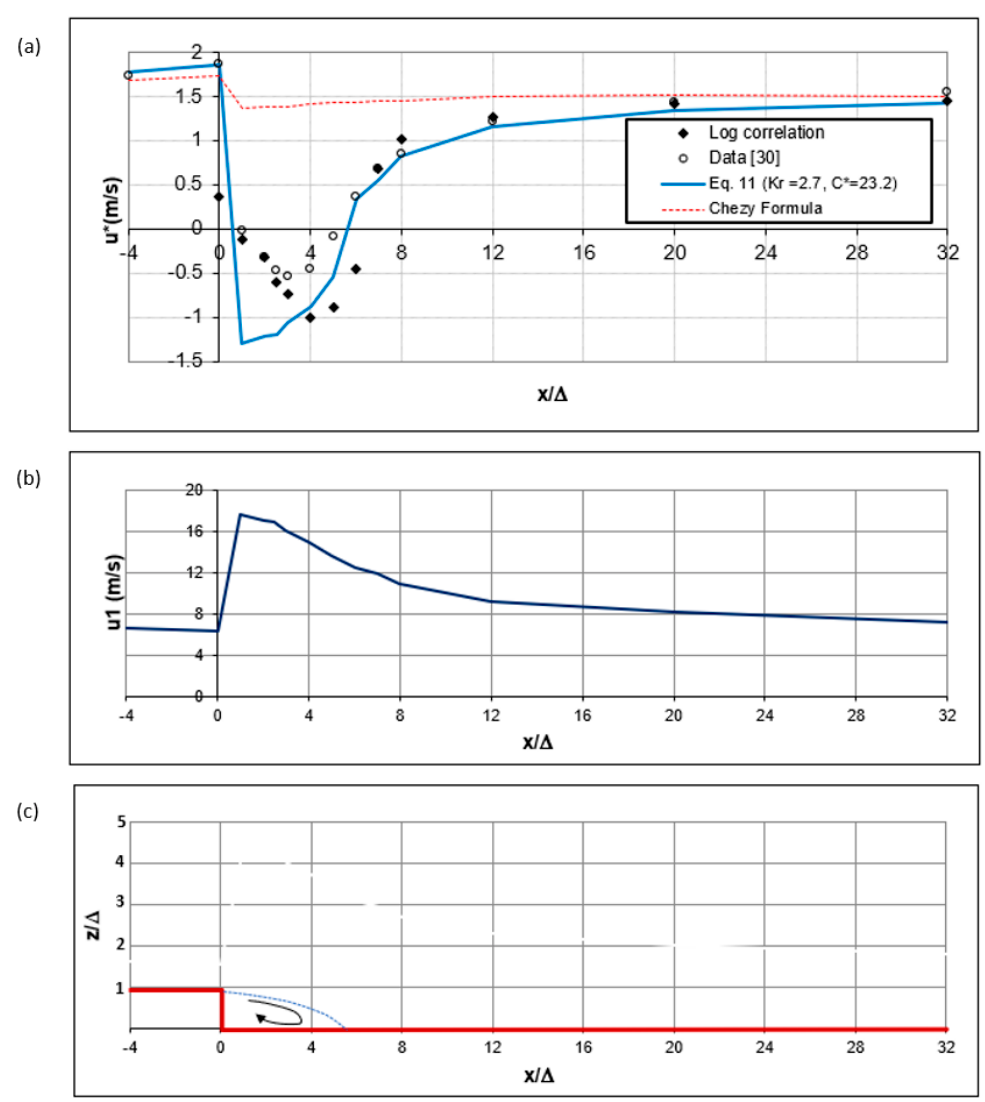
Figure 9. Air flow over a negative step. ( a ) Spatial variation of bed shear velocity, ( b ) integral moment velocity, u 1 , and ( c ) geometry of the step.